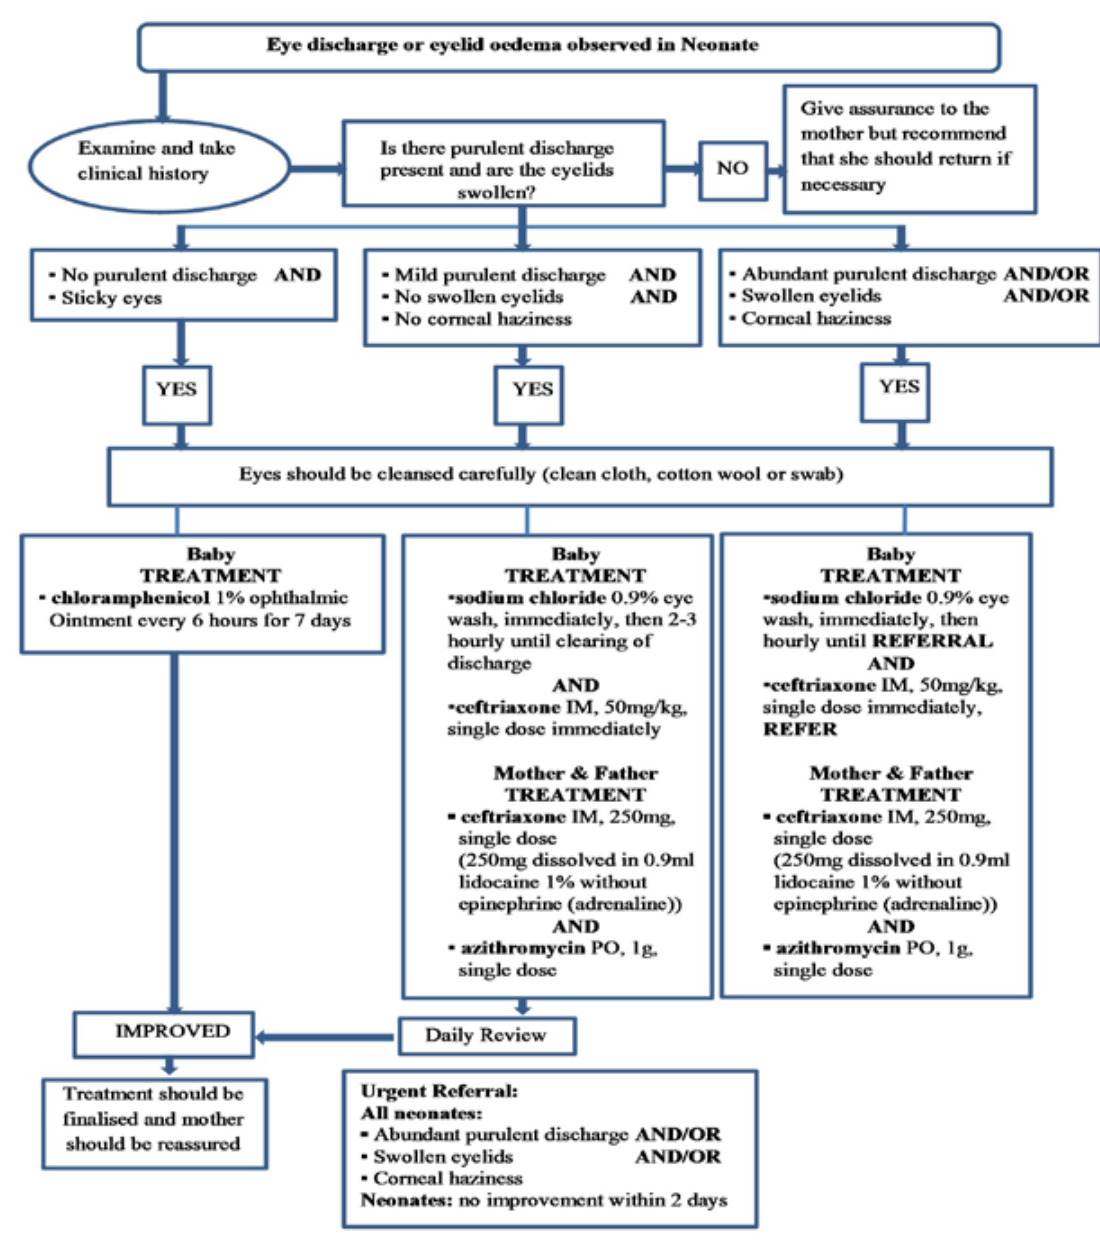
Figure 10: Flowchart of syndromic treatment of syphilis causing neonatal conjunctivitis. (adapted from the revised syphilis (neonatal) flowchart of the Primary Health Care Standard Treatment Guidelines and Essential Drugs List, 2015)